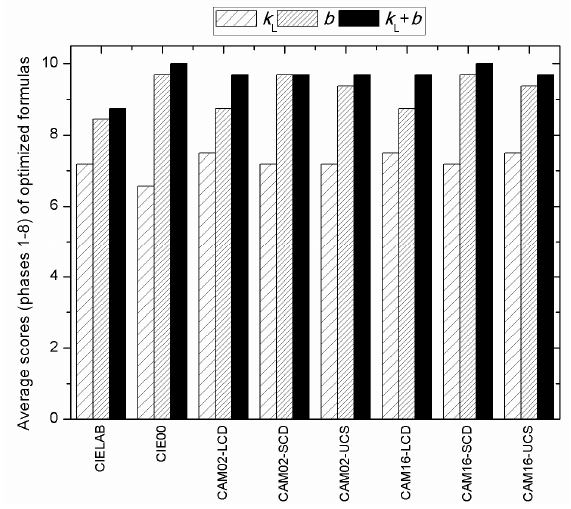
Figure 2. Average scores (phases 1–8) of eight color-difference formulas optimized by lightness par-